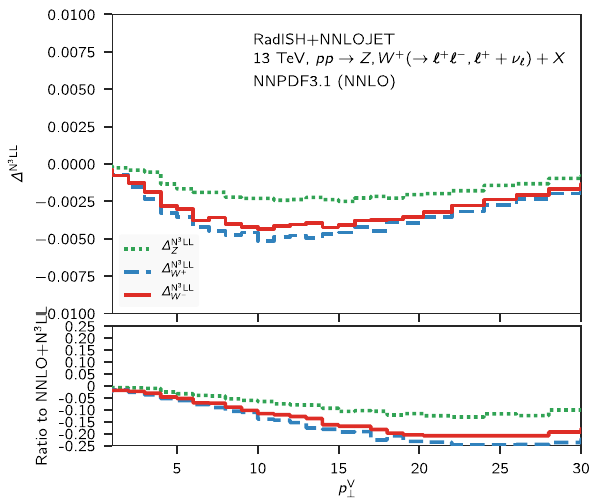
Fig. 3 Difference Eq. (13) between the matched and the resummed predictions for the Z (green, dotted), W + (blue, dashed) and W − (red, solid) normalised distributions. The lower panel shows the ratio of Δ N 3 LL to the N 3 LL+NNLO matched